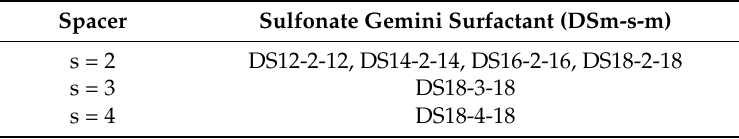
Table 2. Sulfonate Gemini surfactants and their